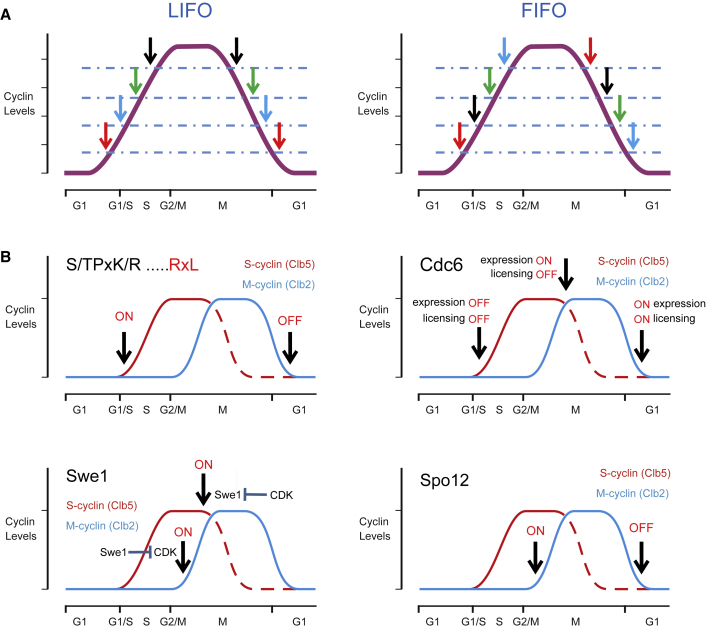
Different Switching Orders Are Generated by Combining the LxF, RxL, and Cks1 Docking Mechanisms(A) In a simple model with uniform CDK activity that triggers the cell cycle switches at different activity thresholds, the switching order would follow the principle of last in, first out (LIFO). Alternatively, the first in, first out order (FIFO, right panel) would provide more complexity in temporal switching.(B) Cyclin-specific targeting and Cks1-mediated docking create a variety of possible thresholds and switching orders (combinations of LIFO and FIFO), as exemplified using the CDK targets studied in the current paper. Top left: the substrate type with a full CDK consensus site and S-CDK-specific RxL motif would provide a low switching threshold that would be useful for targets whose phosphorylation status should be kept constant from the beginning of the cell cycle (ON) until the end of mitosis (OFF). Top right: the Cdc6 mechanism provides a set of three switches involving (1) S-CDK-specific degron phosphorylation at the onset of S phase (Cdc6 expression OFF, licensing OFF); (2) at the beginning of mitotic exit, M-CDK docking of Cdc6 via the LxF motif and Cks1 (Cdc6 expression ON, licensing OFF via shielding); and (3) at the onset of G1 (Cdc6 expression ON, licensing ON). Bottom left: the double-negative feedback mechanism between M-CDK and Swe1 is using multiple LxF motifs and the Cks1 mechanism to introduce two thresholds: (1) M-CDK phosphorylation to prime the site T196, leading to Cks1- and LxF-mediated inhibitory phosphorylation of CDK; (2) multi-phosphorylation of Swe1 and relieving the CDK inhibition. Bottom right: M-CDK-specific phosphorylation of Spo12 via the LxF-hp mechanism provides one high (ON) and one low (OFF) threshold, considering the net CDK activity profile.